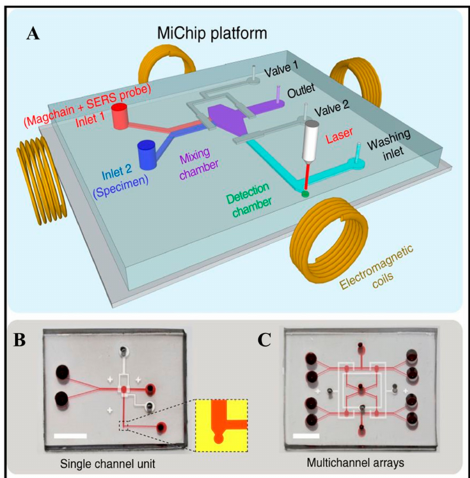
Figure 2. ( A ) Schematic illustration of the Magchain-integrated microchip (MiChip) assay platform: with ( B ) a single-channel unit and ( C ) multiple-channel arrays. Reproduced with permission from Xiong et al. [78].